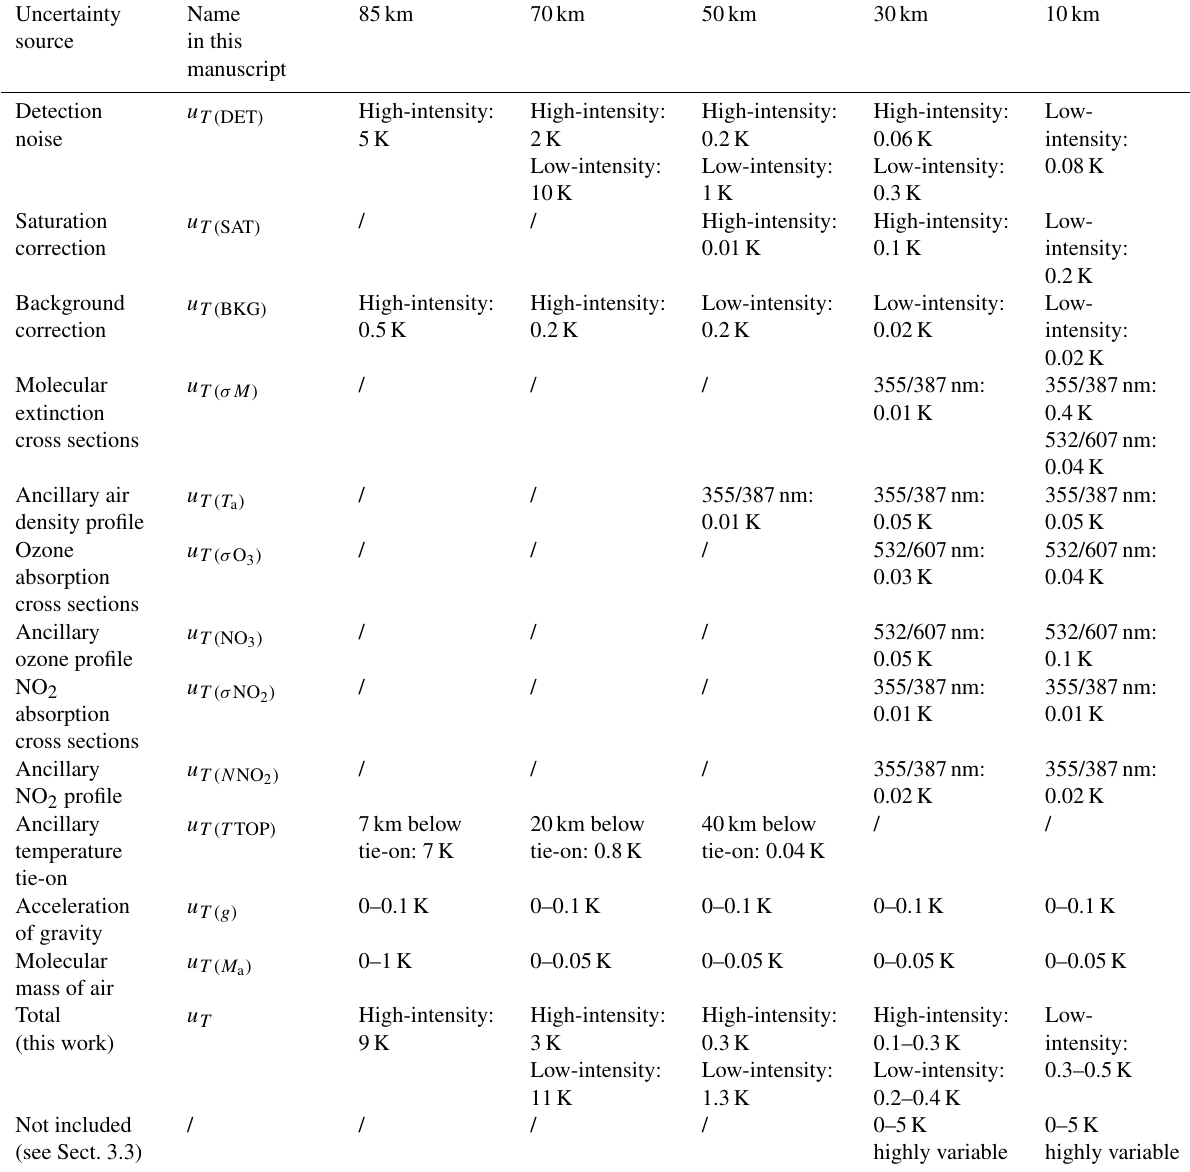
Table 3. Example of uncertainty budget for typical NDACC lidars transmitting at 355 and 532nm (partial overlap, multiple scattering, and particulate backscatter and extinction are not included, but rough estimates are added in the last